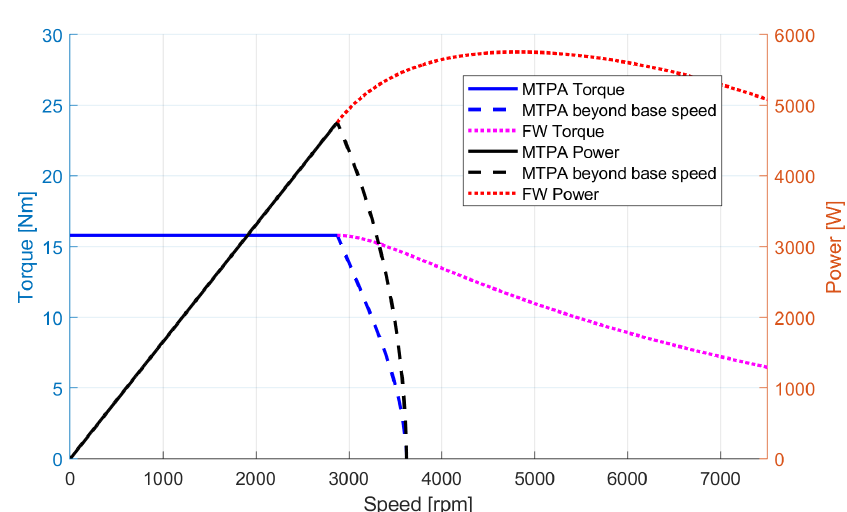
Figure 1. Constant torque and power regions for the reference motor under test.